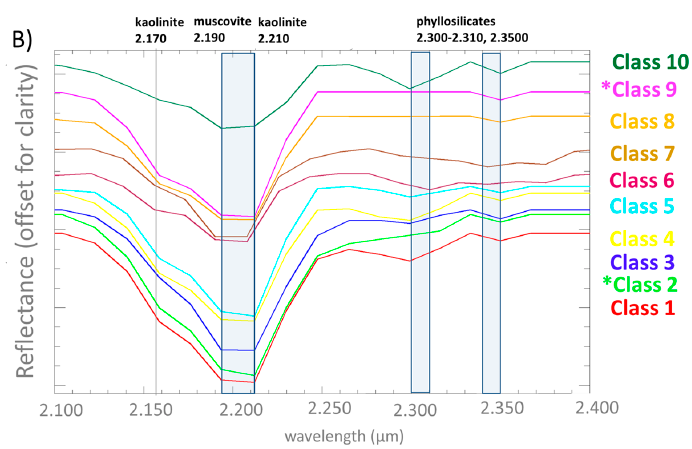
Figure 9. The average class spectrum derived from the HyMap data: ( A ) the VIS/NIR spectral range (0.450–1.200 µm); ( B ) the SWIR range (2.100–2.400 µm).